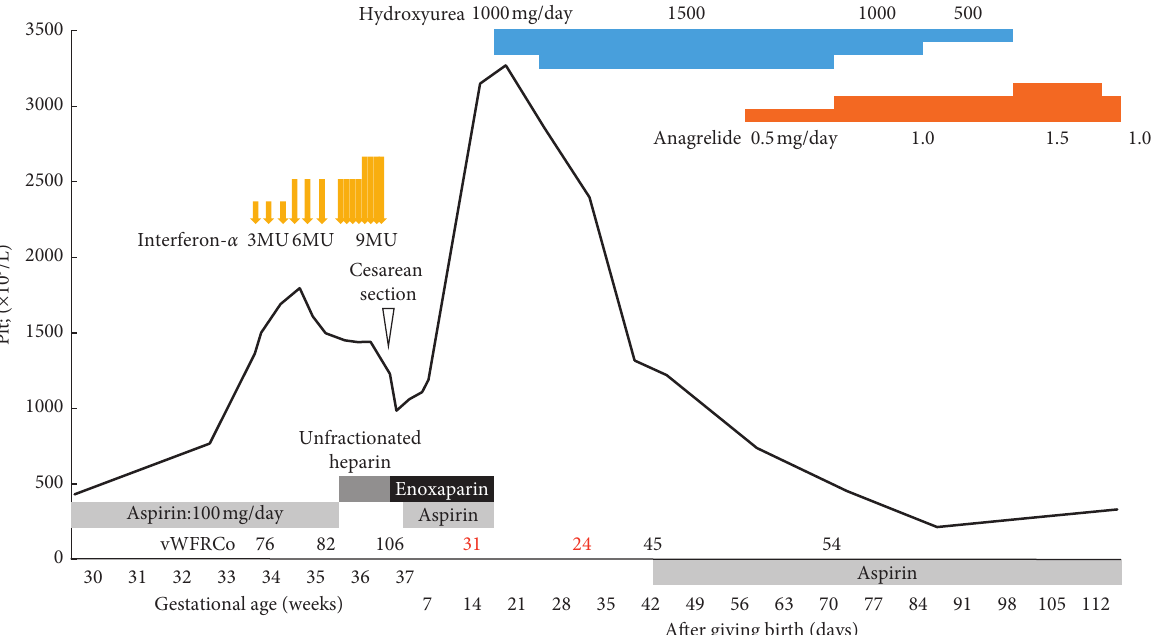
Figure 1: Clinical course and serial changes in the platelet count. MU, million units; VWFRCo, von Willebrand factor ristocetin cofactor